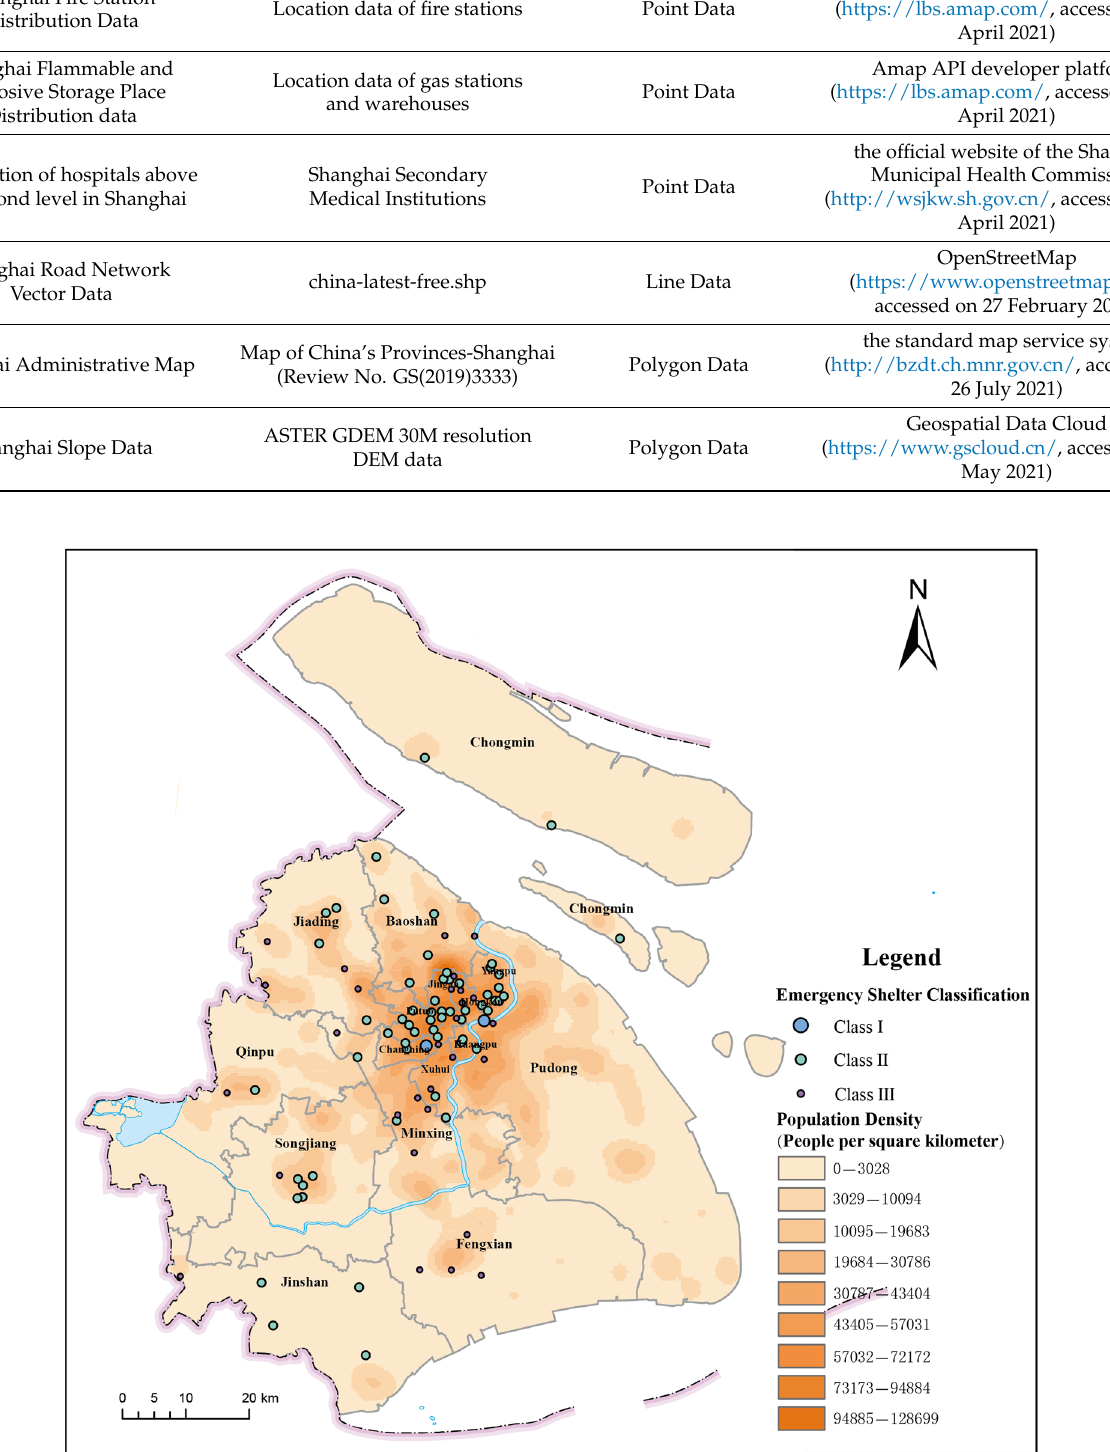
Figure 3. Spatial distribution of the population density in Shanghai.